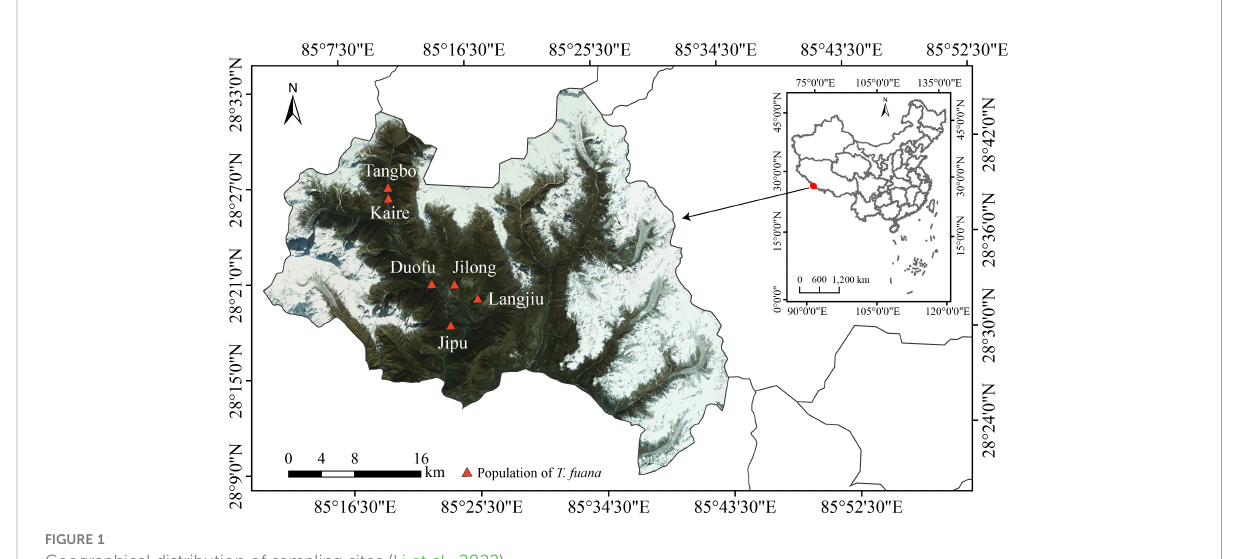
FIGURE 1 Geographical distribution of sampling sites (Li et al.,